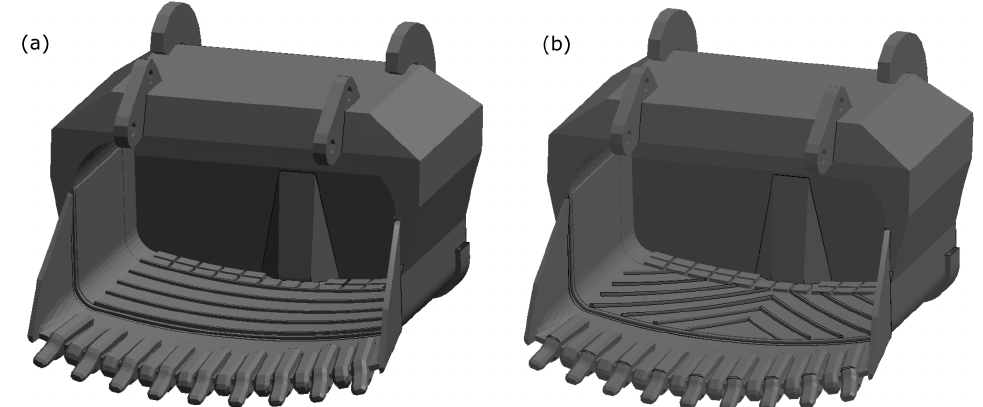
Figure 10. Geometry of the new buckets containing the steel bars at different angles. Bars at 90 ◦ ( a ) and bars at 45 ◦ ( b ) relative the direction of material